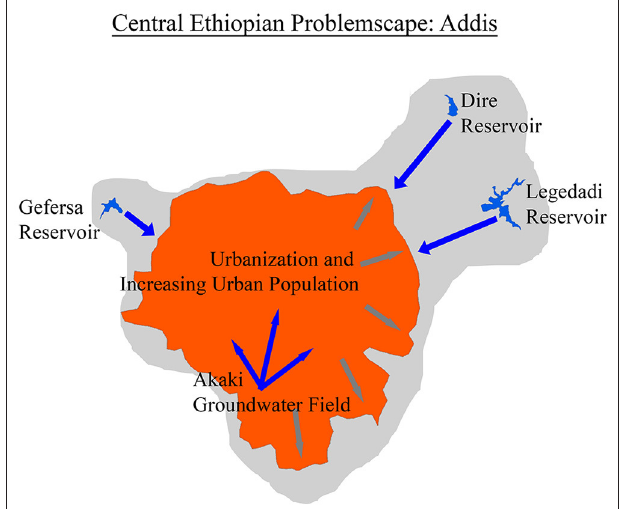
FIGURE 3 | Addis Ababa